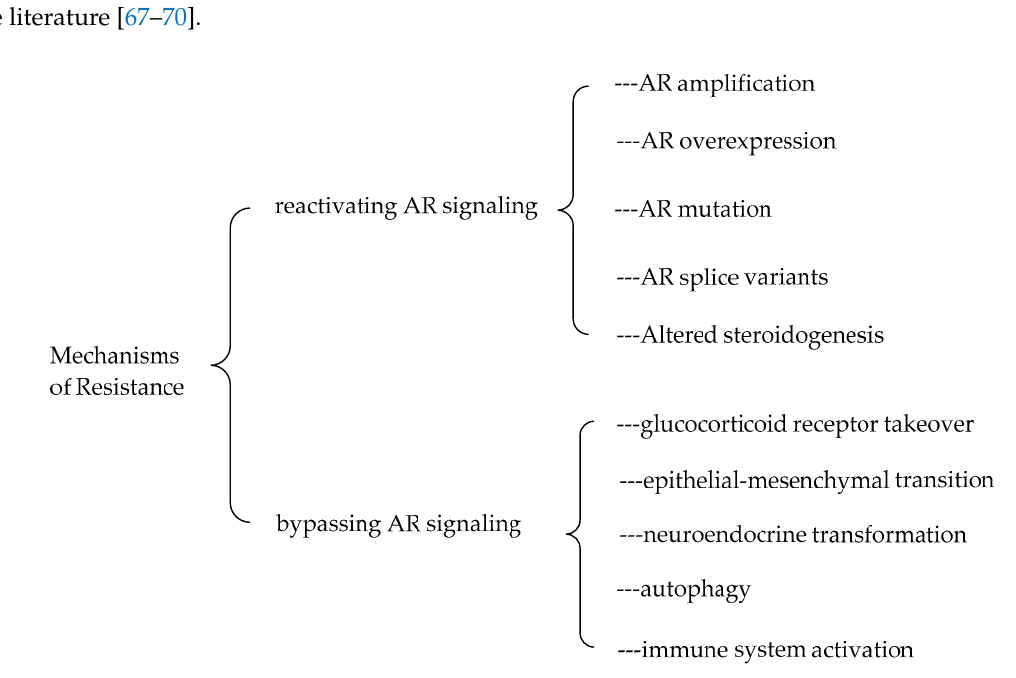
Figure 6. Mechanisms of resistance to the second-generation AR antagonists.